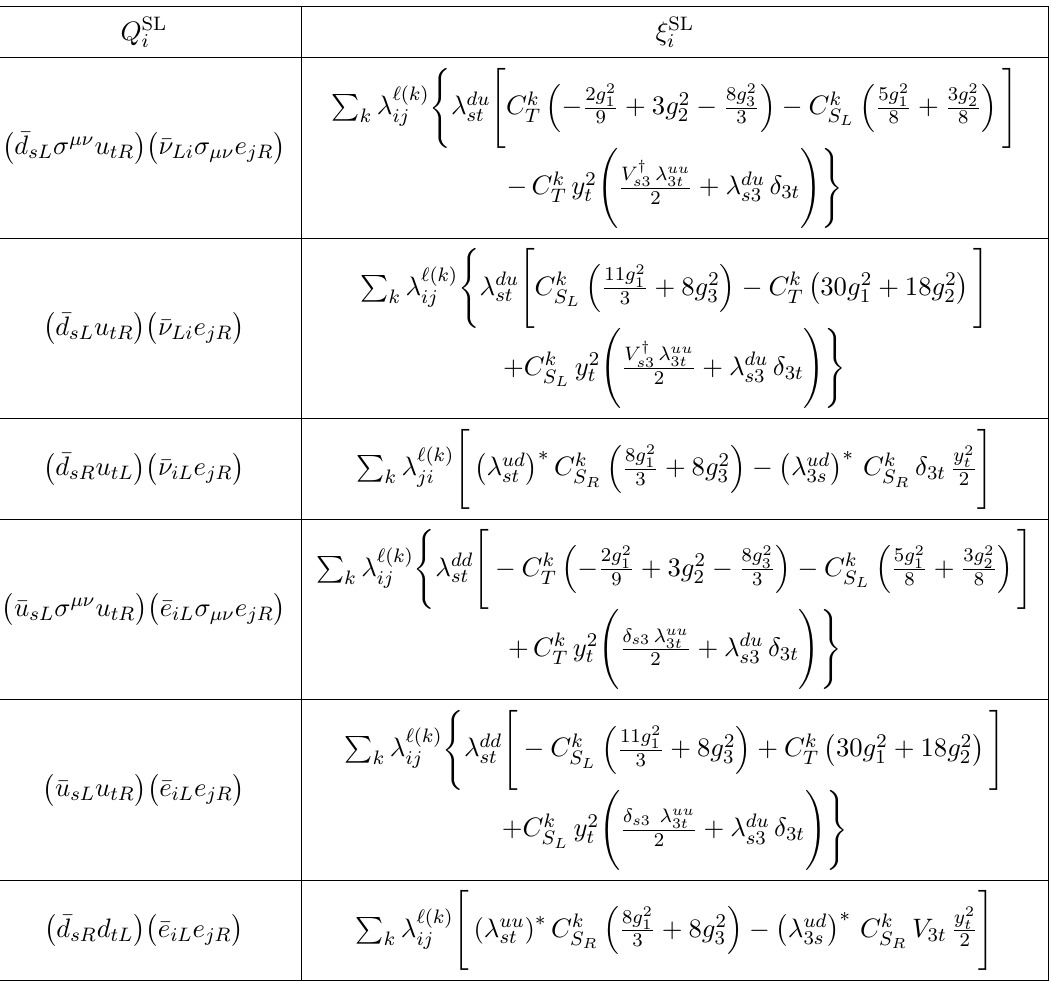
Table 1 . Semileptonic operators Q S L